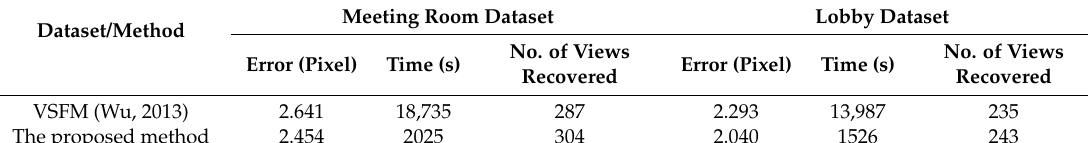
Table 7. Comparison between VSFM and the proposed method.